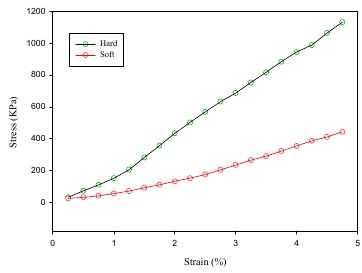
Figure 16. The strain ‐ stress loading curves of two phantoms of different hardness.